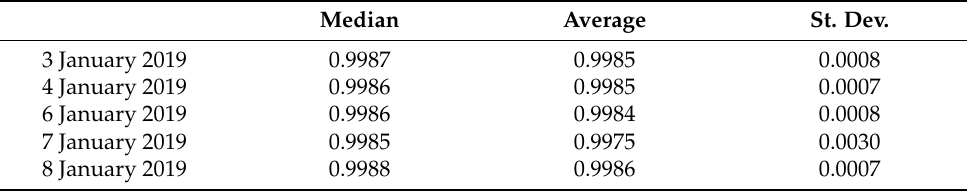
Table 2. Daily statistical parameters for the copolar correlation coefficient: five days in January 2019.